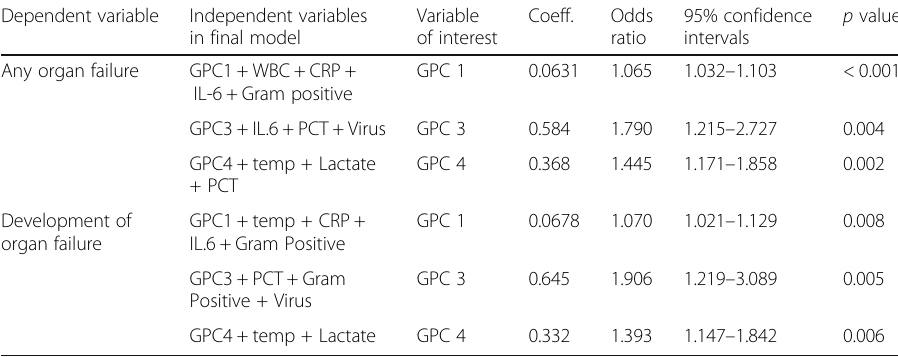
Table 2 Multivariate logistic regression analysis of the association of plasma GPC 1, 3, and 4 with the presence of organ failure and progression to organ failure Dependent variable Independent variables Variable in final model of interest